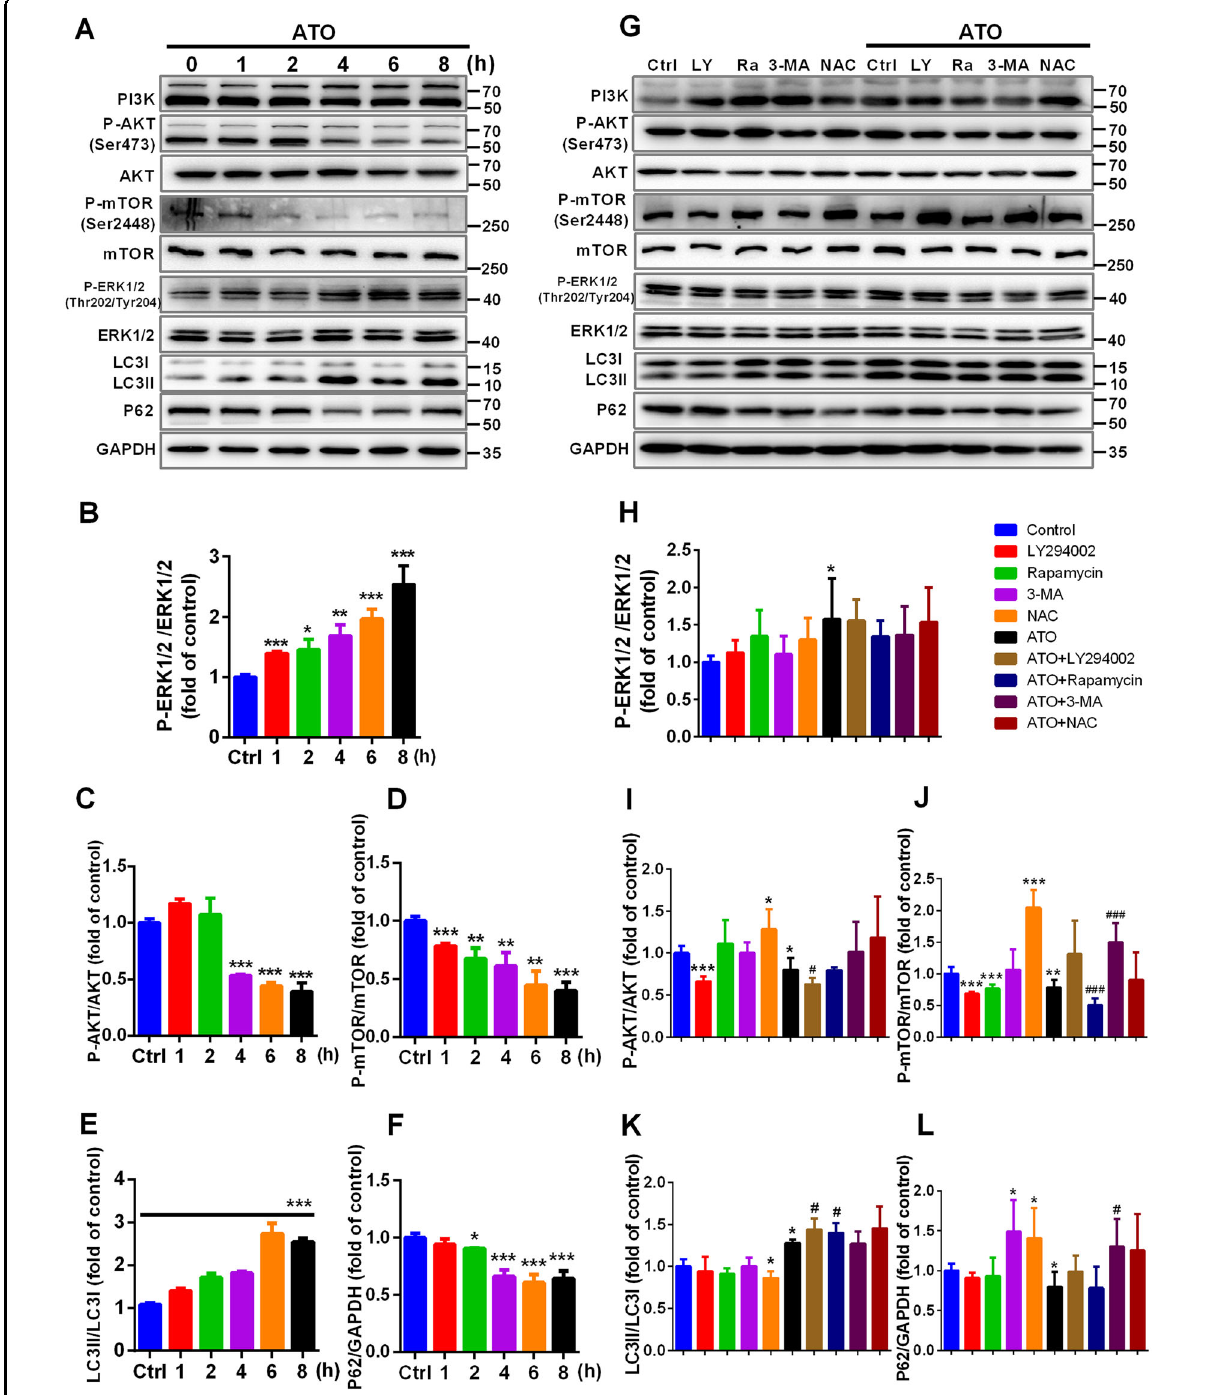
Fig. 6 ATO induces autophagy in macrophages by inhibiting the PI3K/AKT/mTOR pathway. A – F WB analysis of autophagy signaling pathway proteins, LC3II/LC3I and p62 in RAW264.7 cells treated with 2.5 μ M ATO for 1, 2, 4, 6, 8 h. G – L WB analysis of autophagy signaling pathway proteins, LC3II/LC3I and p62 in RAW264.7 cells pre-treated with LY294002 (10 nM), rapamycin (100 nM), 3-MA (2.5 mM), or NAC (5 mM) for 2 h respectively, and then treated with or without 2.5 μ M ATO for 2 h. * p vs. Control, # p vs. ATO. Data were expressed as mean ± SD from 3 independent-experiments. * p < 0.05, ** p < 0.01, *** p < 0.001, # p < 0.05, ### p < 0.001, and ns means non-signi fi